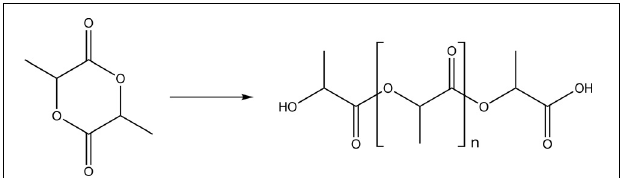
FIGURE 2 | Schematic synthesis of poly(lactic acid) from lactide.